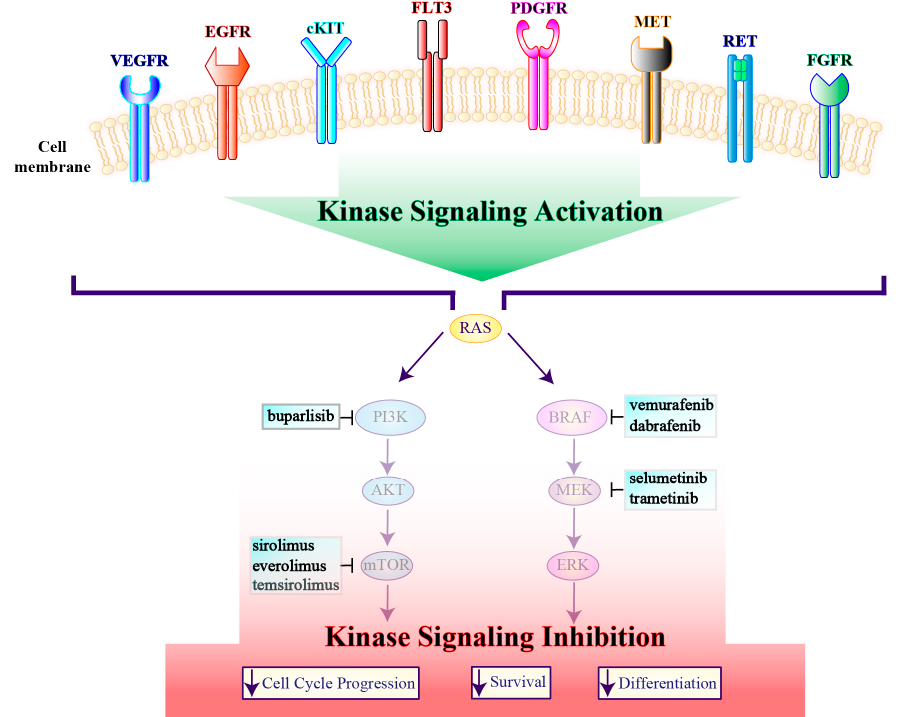
Figure 6. Strategies that target downstream mediators of receptor tyrosine kinases. RTK stimulation causes signaling activation that is blocked by inhibition of downstream mediators decreasing cell cycle progression, survival and differentiation. The panels report the downstream mediators inhibitors used in thyroid cancer stratified according to their molecular target specificity and selectivity. VEGFR, vascular endothelial growth factor receptor; EGFR, epidermal growth factor receptor; c-KIT, Mast/Stem Cell Growth Factor Receptor Kit; FLT3, FMS-like tyrosine kinase 3; PDGFR, platelet-derived growth factor receptor; MET, proto-oncogene, receptor tyrosine kinase; RET, rearranged during transfection; FGFR, fibroblast growth factor receptor; PI3K, phosphoinositide 3-kinase; AKT, V-Akt Murine Thymoma Viral Oncogene Homolog; mTOR, Mammalian Target of Rapamycin; BRAF, B-Raf proto-oncogene; MEK, Mitogen-Activated Protein Kinase; ERK, Extracellular Signal-Regulated Kinase.